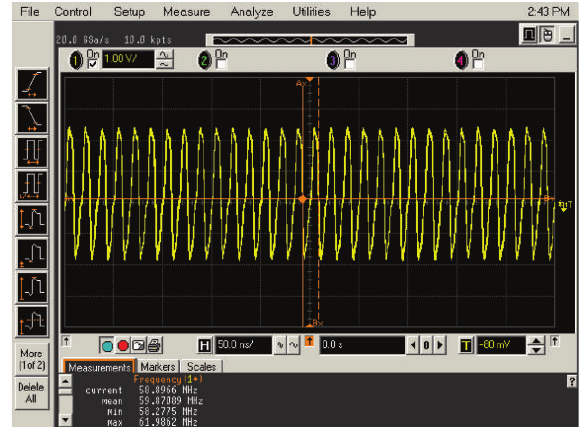
Figure 32: Measurement results from output signal F O [9]. The measured signal is F O [9] / 8. Table 1: Comparison